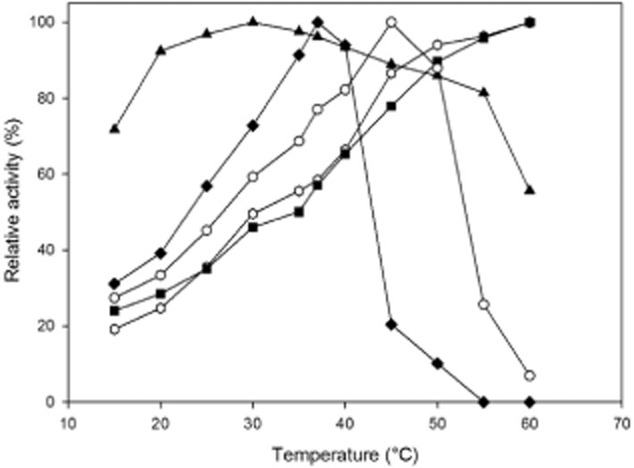
Effect of temperature on activities of Udhs from A. tumefaciens, F. pelagi, O. granulosus, S. viridochromogenes and P. syringae presented as relative activities., Hexagon, F. pelagi UDH; Squares, A. tumefaciens UDH; Triangles, O. granulosus UDH; Circles, S. viridochromogenes UDH; Diamonds, P. syringae UDH.